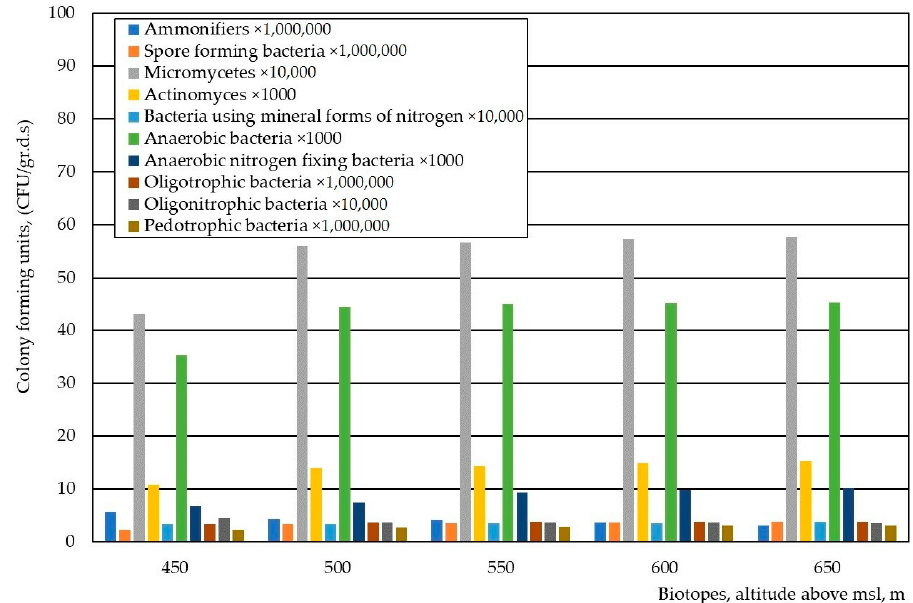
Figure 1. Microbial community composition (CFU/gr.d.s.) in the soils of the forest ecosystem. The data are statistically significant, p < 0.05, x ± SD, n = 4.